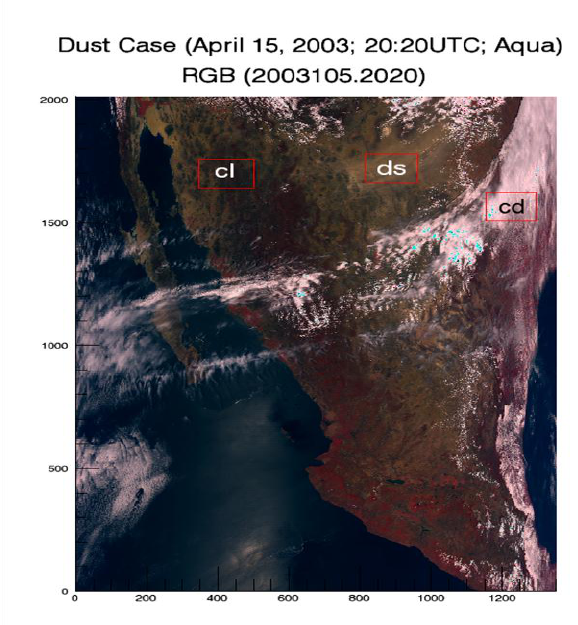
for dust (yellow x’s) and cloud (black 2